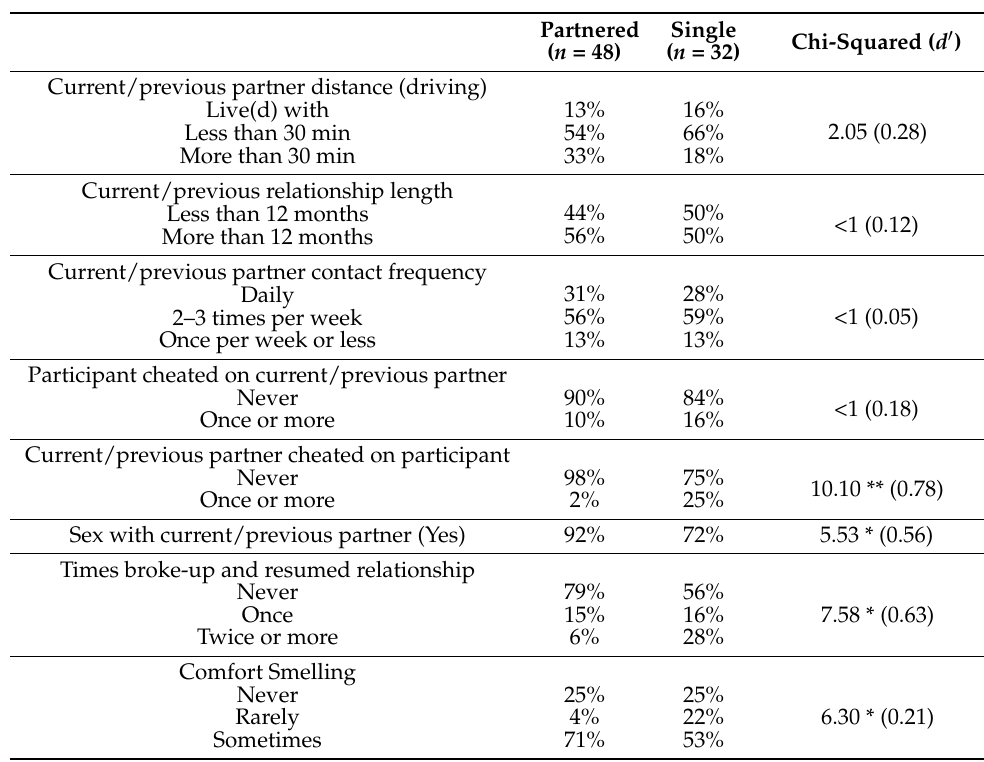
Table 2. Descriptive statistics and comparisons of Relationship Characteristics Survey data by relationship